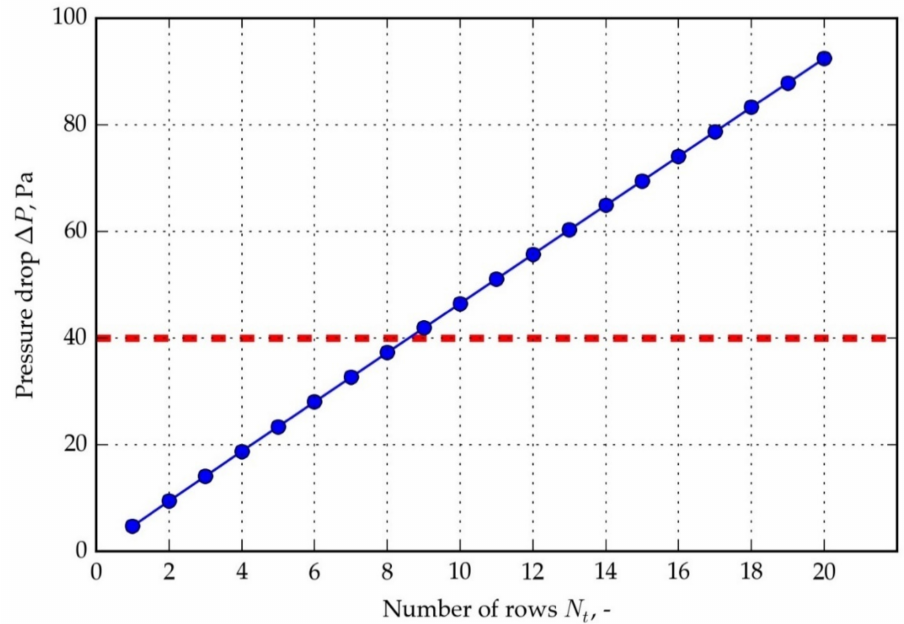
Figure 10. Pressure drop for HPHE vs. number of rows, for inlet cold air temperature 10 ◦ C and hot air inlet temperature 30 ◦